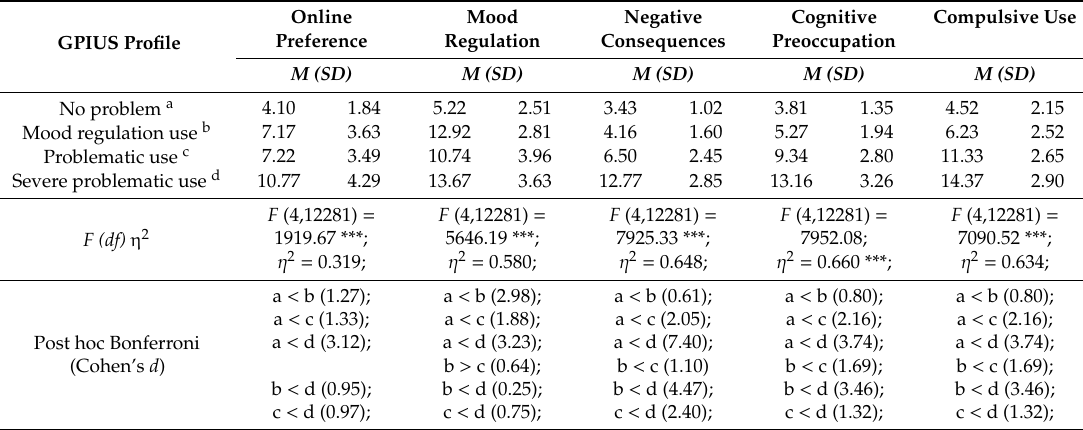
Figure 1. Profiles of problematic internet use (standardized scores). Table 3. Di ff erences in the dimensions of the GPIUS-2 as a function internet usage profile ( n =